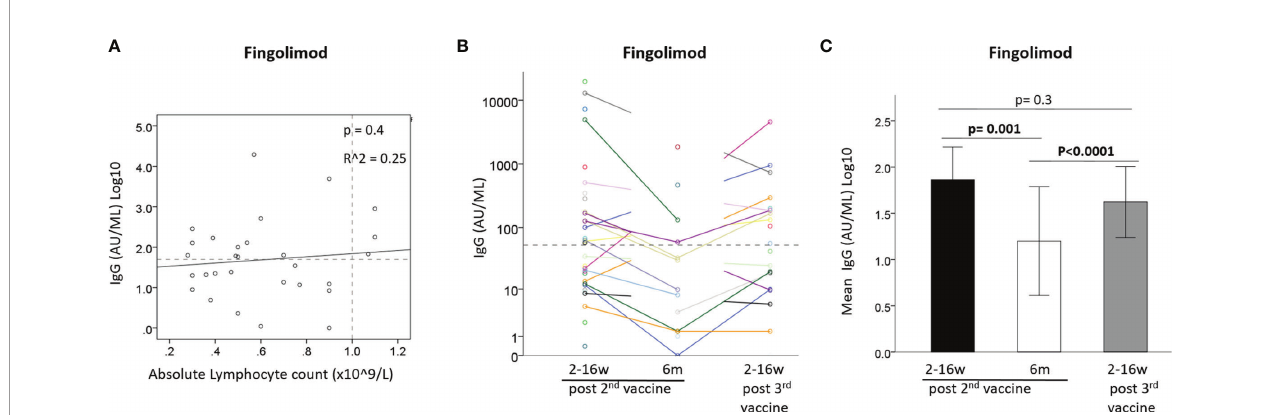
FIGURE 3 | (A) Correlation between IgG after 2 nd vaccine and absolute lymphocyte count in Fingolimod-treated patients (N=29). (B) IgG levels of Fingolimod-treated patients at 3 time-points: ≤ 3months and 6 months from 2 nd vaccine and ≤ 3 months from 3 rd vaccine. (C) Mean IgG levels in Fingolimod-treated patients at 3 time- points: ≤ 3months and 6 months from 2 nd vaccine and ≤ 3 months from 3 rd vaccine. Dashed horizontal grey line represents minimum seropositive border (log10 (50AU/ml), dashed vertical line represent normal lymphocyte count